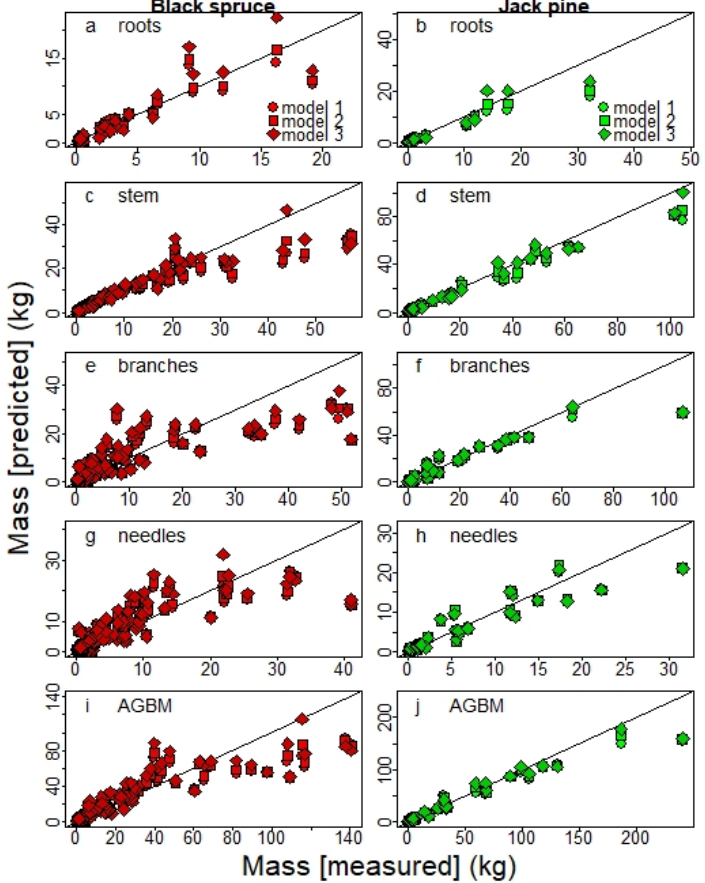
Figure 3. Roots ( a , b ) , stem ( c , d ), branches ( e , f ), needles ( g , h ) and aboveground biomasses ( i , j )